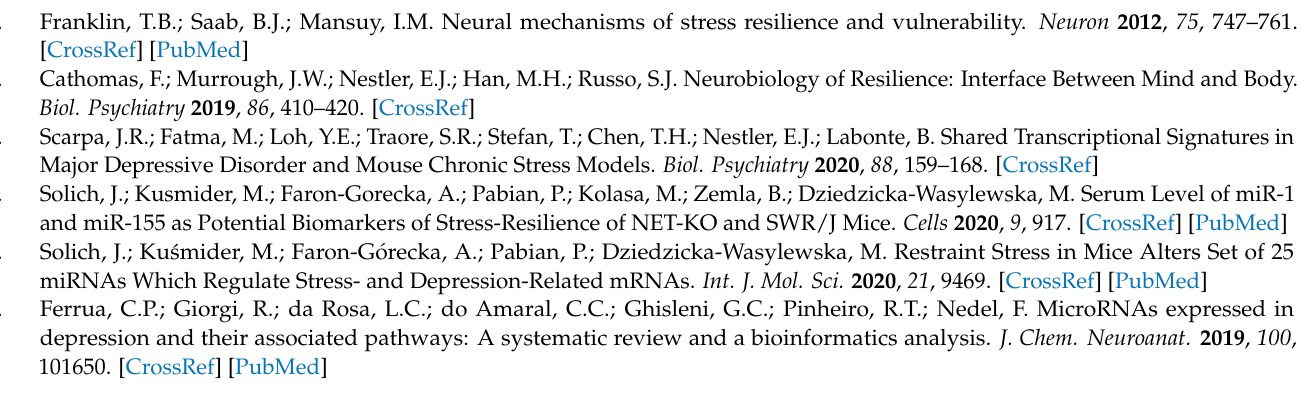
Figure S1: The expression of mRNA encoding Bdnf in the prefrontal cortex (PFC) of wild-type (WT), norepinephrine transporter knock-out (NET-KO) and Swiss (SWR/J) mice under the control condition (CON) and following stress